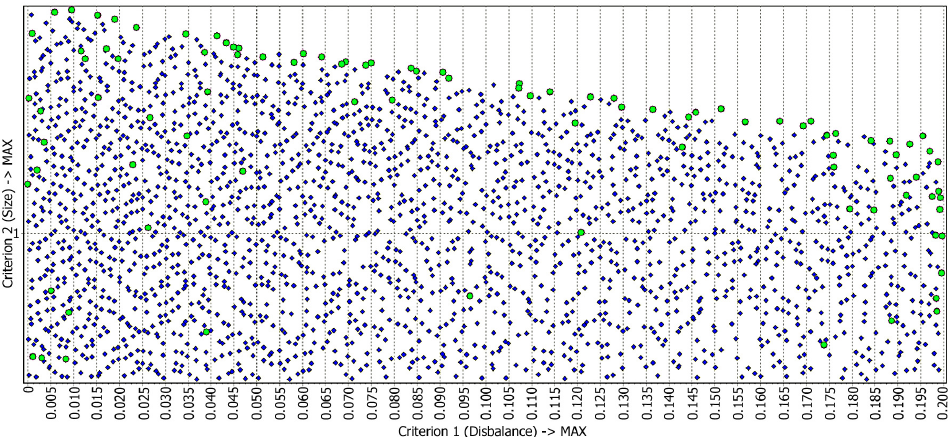
Figure 3. The set of solutions in the space of criteria: K 1 and K 2 . Blue dots denote admissible solutions, green circles-Pareto optimal solutions.